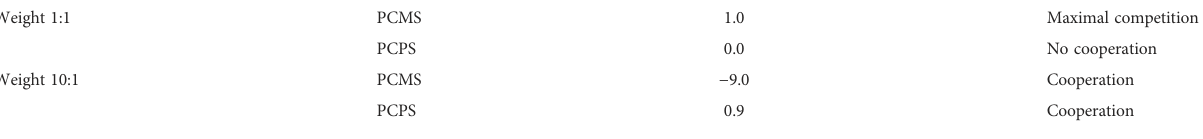
TABLE 5 The prediction of interaction between species D. pigrum and S. aureus using Equations (13) and (14).